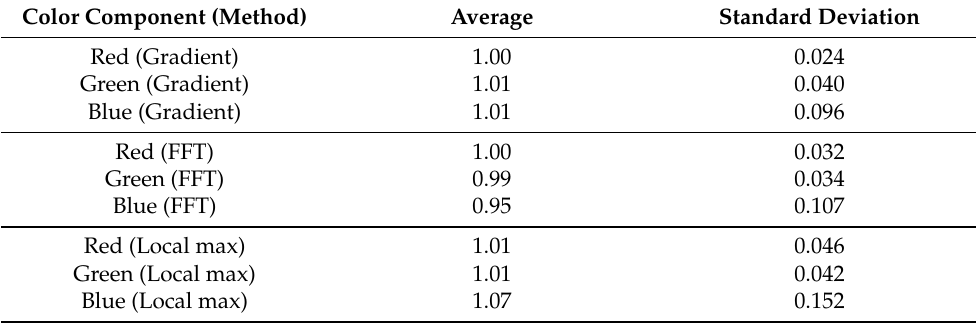
Table 1. Statistical data for 45-s video recordings.